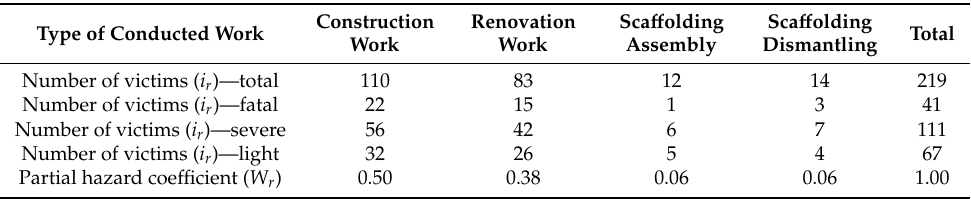
Table 2. Type of conducted work.